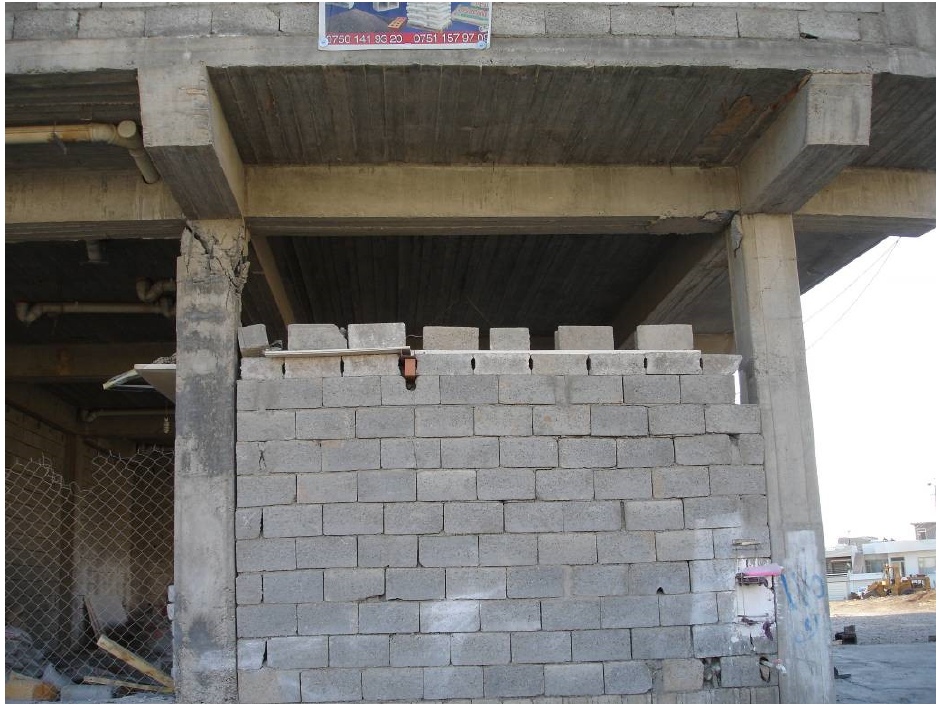
Figure 1. Heavy shear damage to a short column of a building in Darbandikhan.